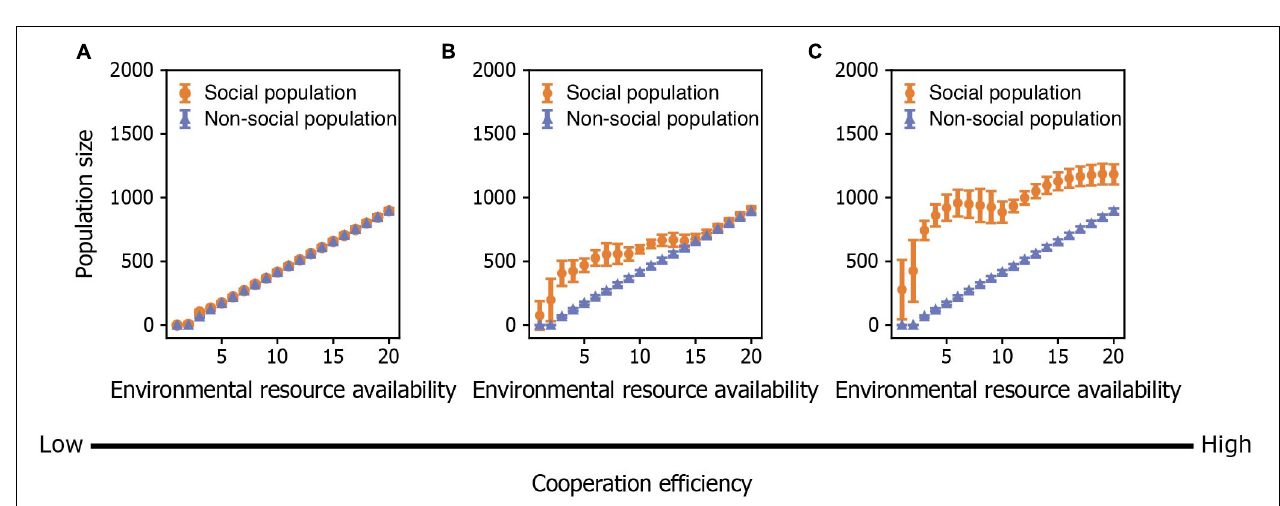
FIGURE 4 | A comparison of the relationship between total reproductive output and cooperative benefits of groups in different environments. (A,B) The total reproductive output of groups in relation to their cooperative benefit in (A) harsh and (B) benign environments. Each point represents a group’s condition. The results are extracted from the early stage (the end of the 100th time step) of the simulations to see how cooperative benefits influence the reproductive output at the evolving stage.